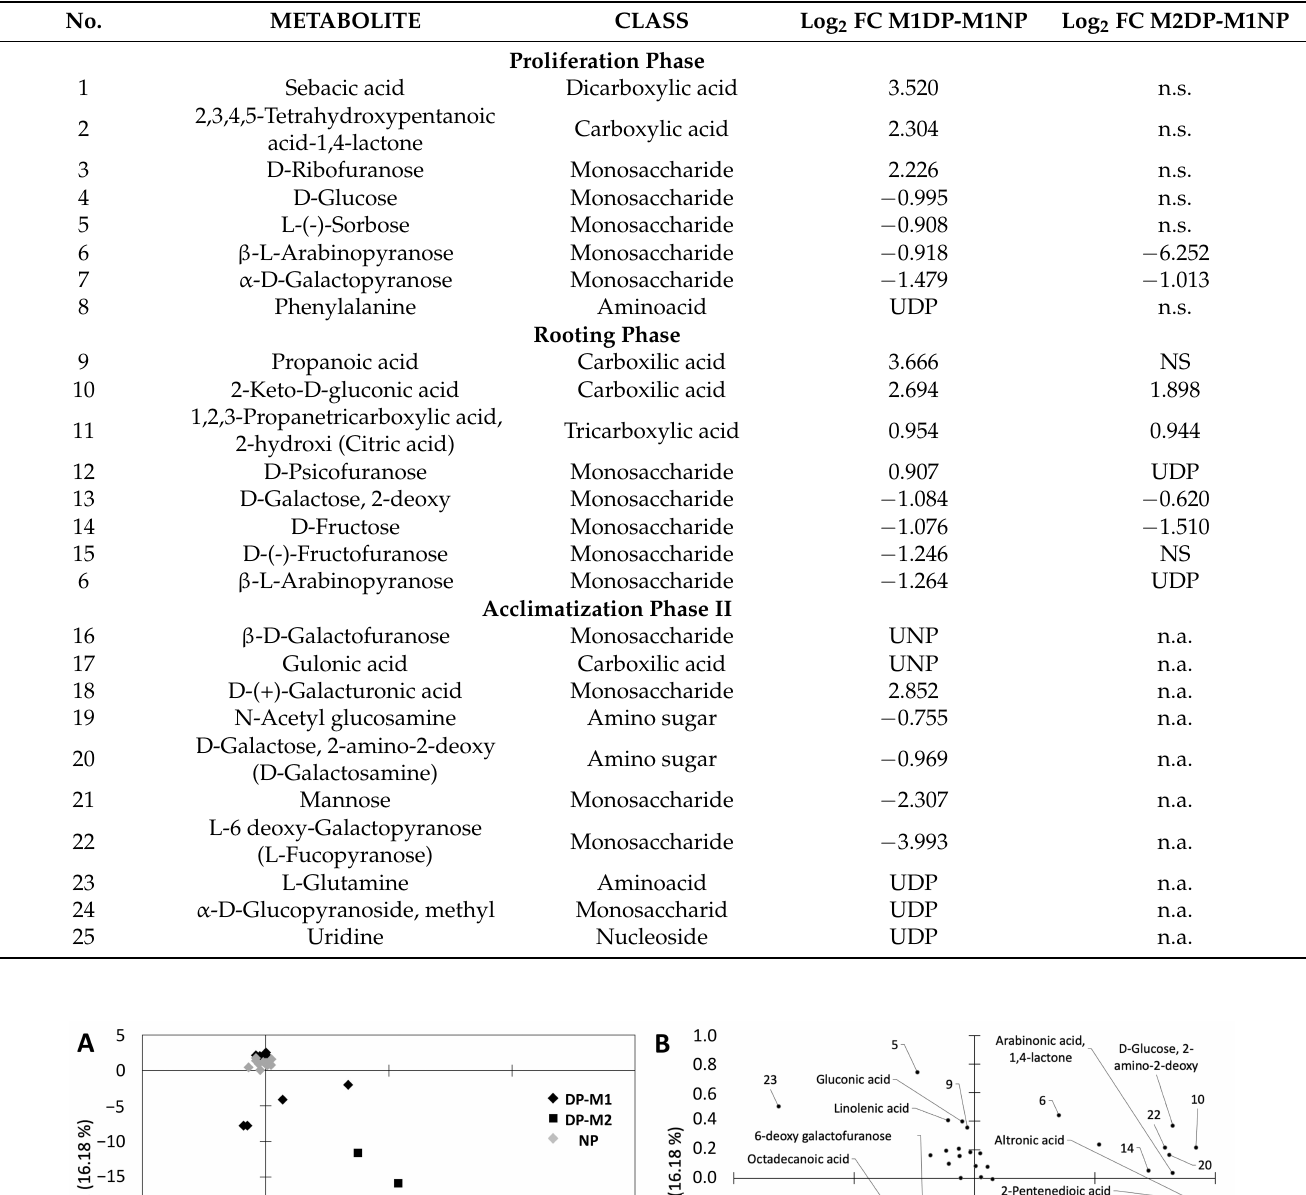
Table 1. Differentially accumulated metabolites in dwarf plants (DF) when compared with normal plants (NP) ( p < 0.05).